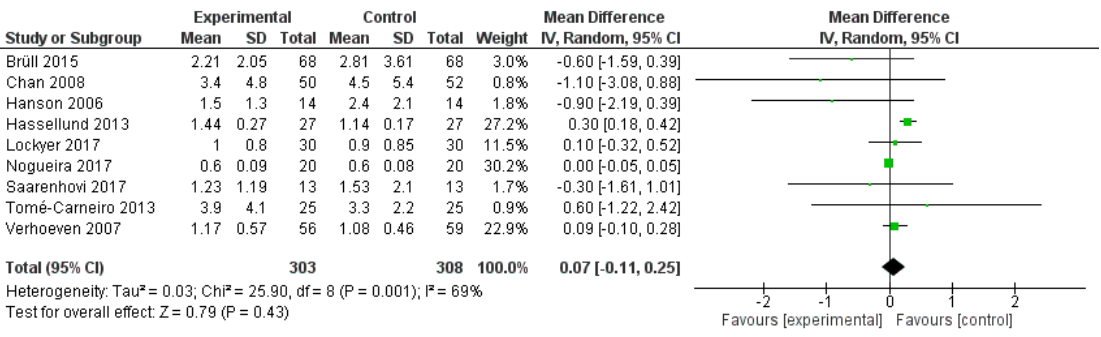
Figure 7. Pooled analysis of association between polyphenol intake and high-sensitive C-reactive protein (hs-CRP).